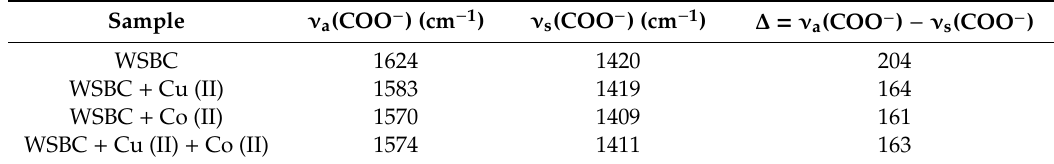
Table 5. Calculated values of ∆ υ (COO −